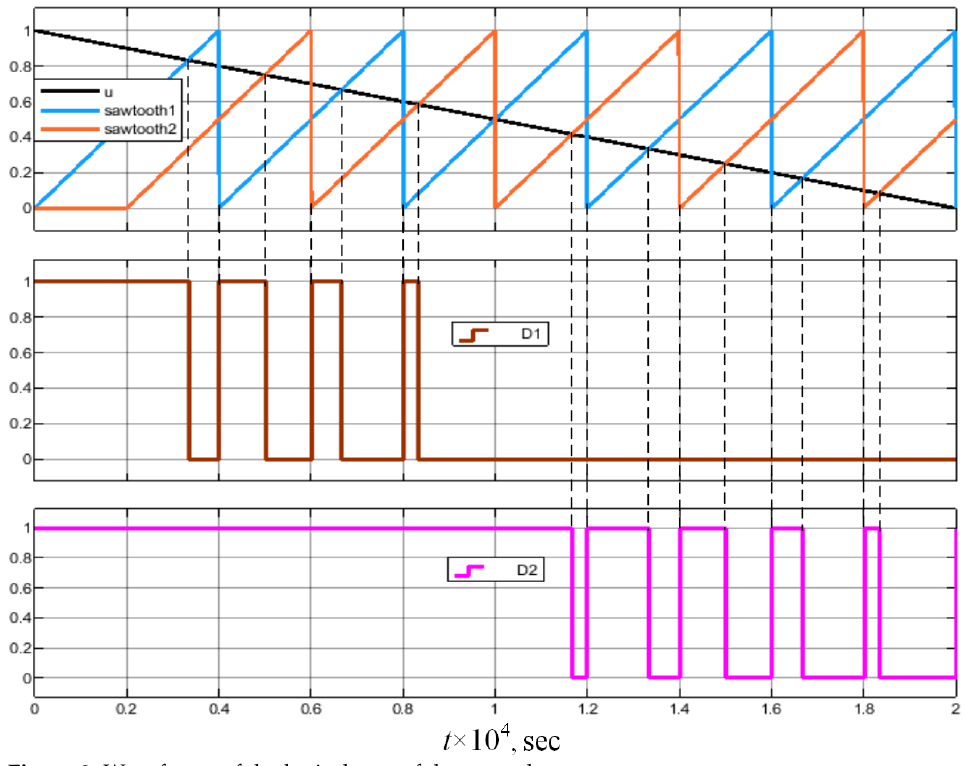
Figure 8. Waveforms of the logical part of the control system.